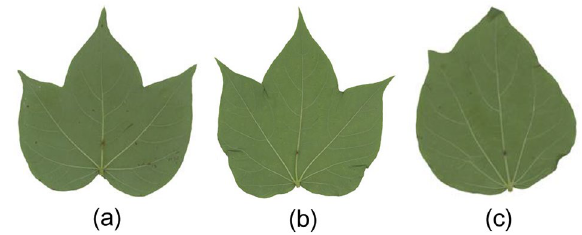
Figure 4. Example of different types of cotton leaf